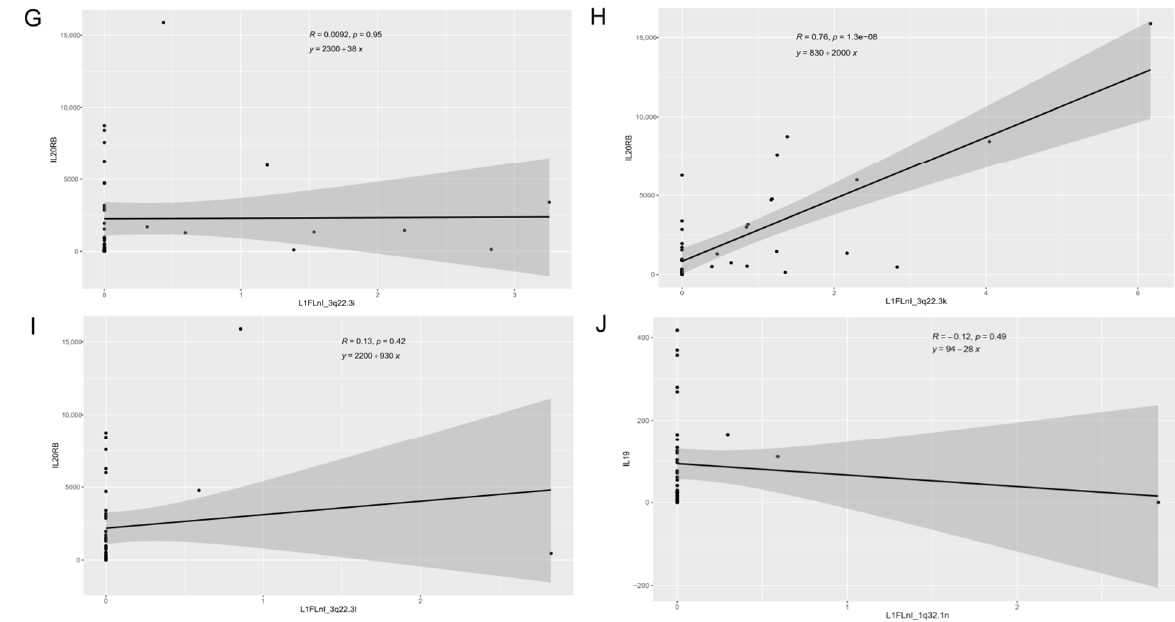
Figure 4. Interleukin-20 gene family and retroelement expression. Scatter plots show ( A ) IL-19 x ERVLE_1q32.1e , ( B ) IL20RA vs. HERVH_6q23.3 , ( C ) IL20RA2 vs. HERVH_6q23.3 , ( D ) IL20 vs. L1FLnI_1q32.1n , ( E ) IL20RB vs. L1FLnI_3q22.3g , ( F ) IL20RB vs. L1FLnI_3q22.3h , ( G ) IL20RB vs. L1FLnI_3q22.3i , ( H ) IL20RB vs. L1FLnI_3q22.3k , ( I ) IL20RB vs. L1FLnI_3q22.3l and ( J ) IL19 vs. L1FLnI_1q32.1n . Pearson correlation coefficient (R), p -value (p) and linear equation are